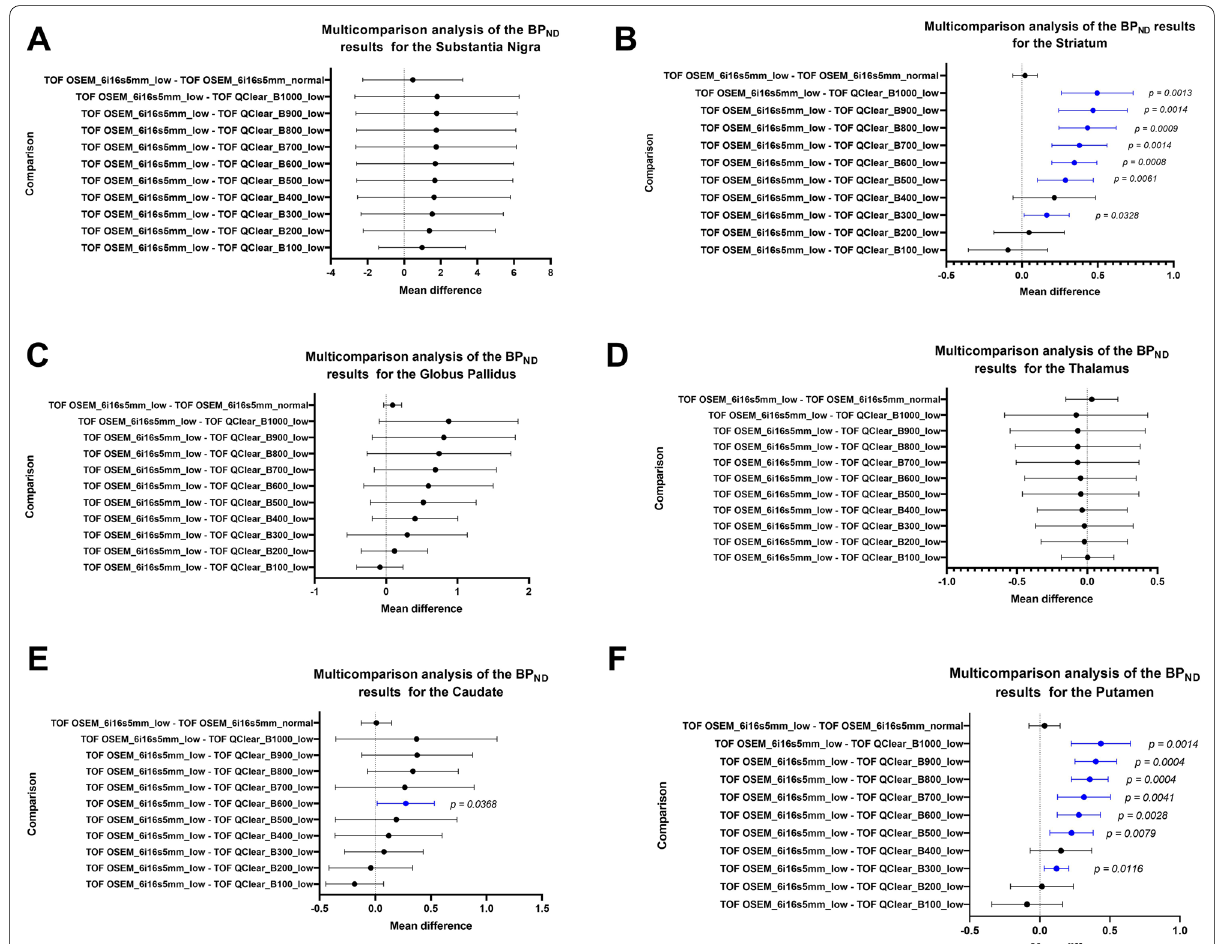
Fig. 6 Multicomparison analysis of the BP ND results obtained for all structures when images reconstructed the standard OSEM 6iterations 16subsets and 5 mm filter and with the Q.Clear reconstructions with different β values. Note the statistically significant results included on the